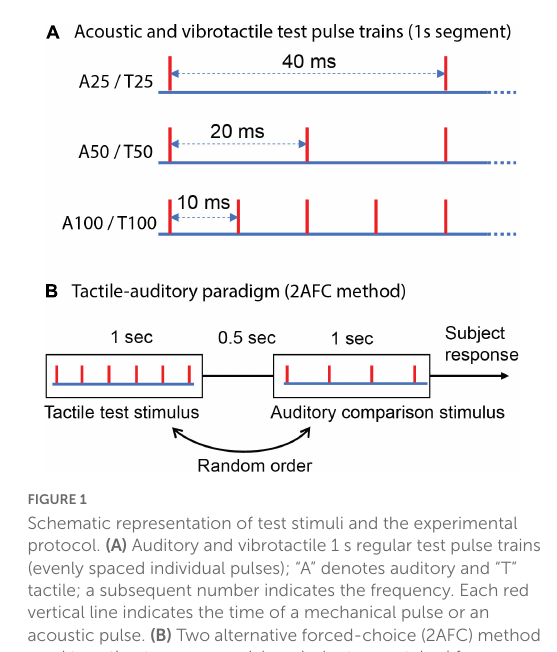
FIGURE1 Schematic representation of test stimuli and the experimental protocol. (A) Auditory and vibrotactile 1 s regular test pulse trains (evenly spaced individual pulses); “A” denotes auditory and “T” tactile; a subsequent number indicates the frequency. Each red vertical line indicates the time of a mechanical pulse or an acoustic pulse. (B) Two alternative forced-choice (2AFC) method used to estimate cross-modal equivalent or matched frequency for test stimuli, tactile-auditory paradigm is presented as an example [i.e., a tactile test pulse train compared with six different regular acoustic pulse trains spanning a range of frequencies to obtain an auditory point of subjective equality (PSE)].